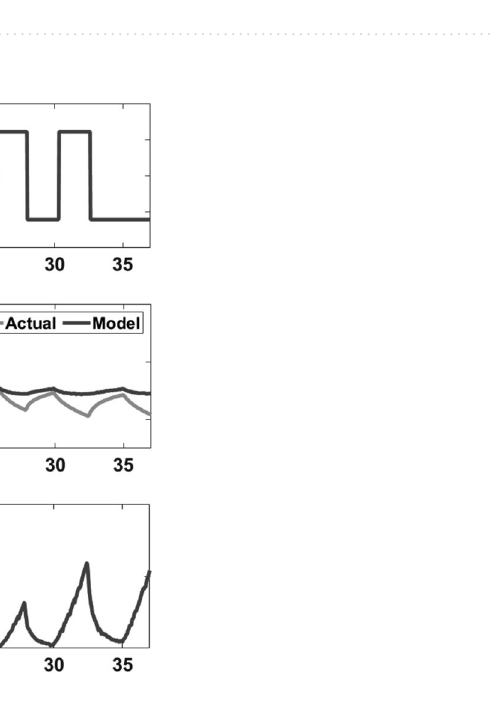
Figure 7. Model validation. Top: applied PRBS voltage to the IPMC (with a peak voltage of 2.3 V). Middle: the actual and estimated tip displacement of the IPMC in the x- direction. Bottom: the square error